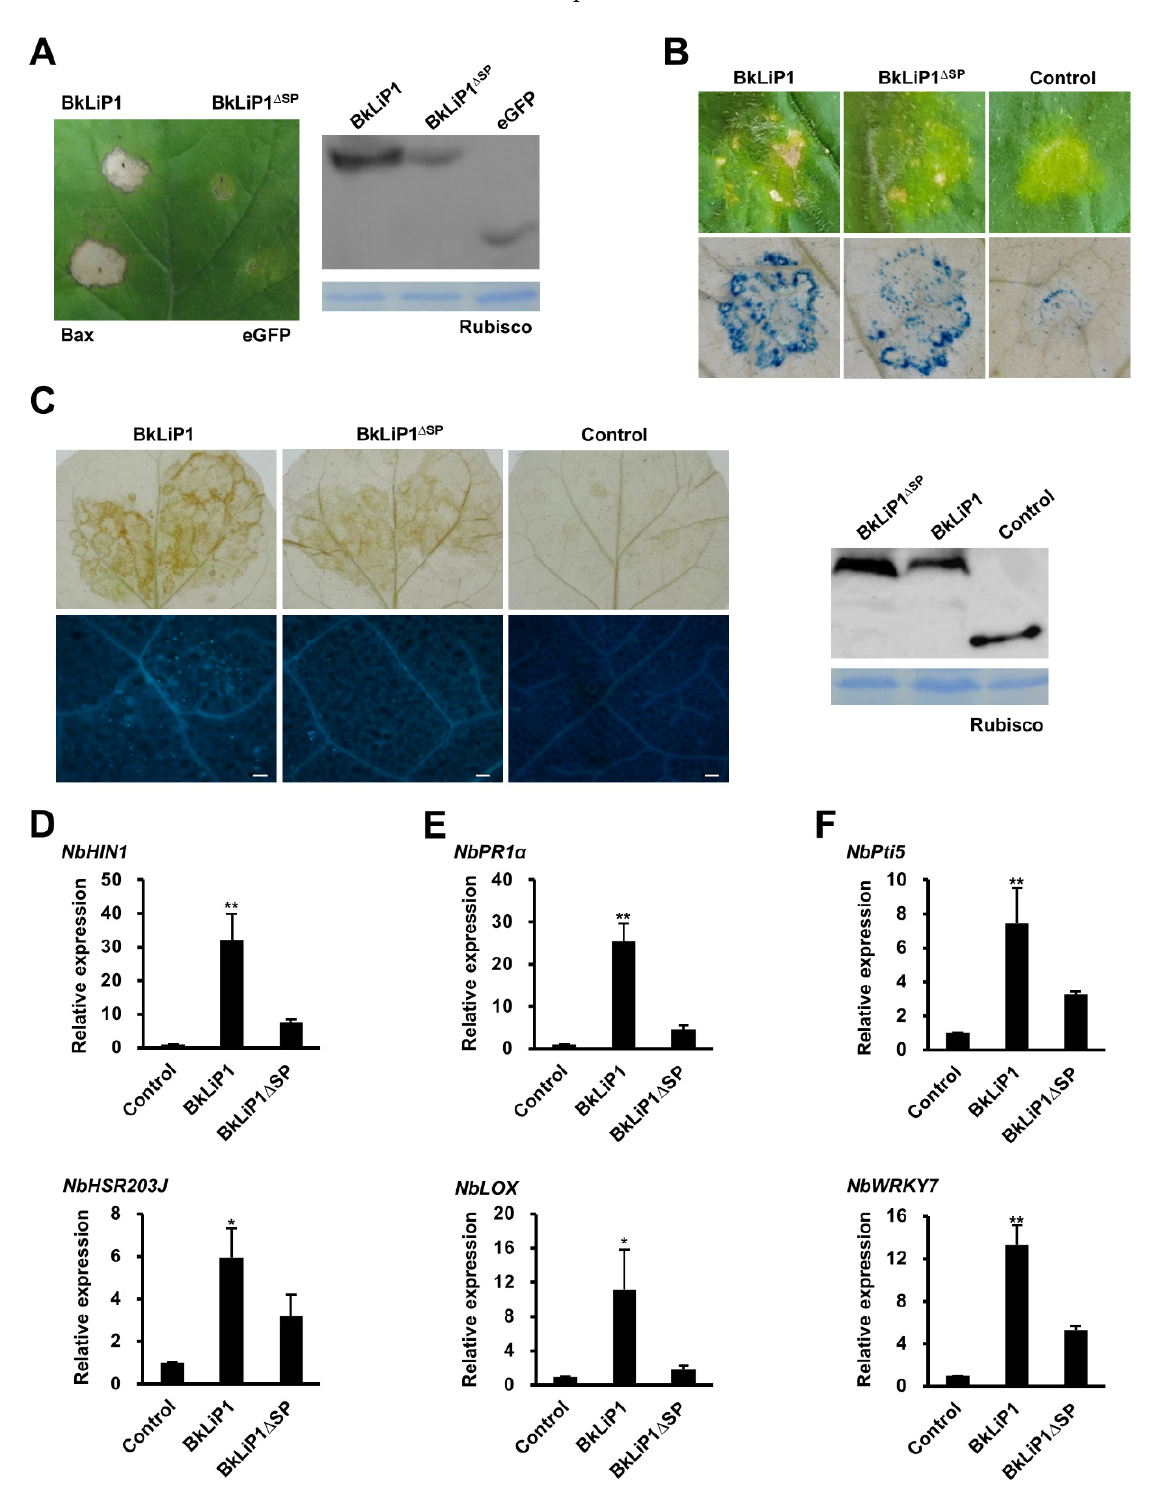
Figure 6. Immune responses triggered by BkLiP1 in N. benthamiana . ( A ) Programmed cell death triggered by transient expression of BkLiP1 in N. benthamiana leaves at 7 dpi infiltrated with Agrobacterium tumefaciens containing PVX-BAX, PVX-BkLiP1, PVX-BkLiP1 ∆ SP , and PVX-GFP vector, respec- tively. Western blot analysis was conducted to confirm protein expression with a Flag tag protein in N. benthamiana leaves 48 h after infiltrated by A. tumefaciens cells. ( B ) Cell death in N. benthamiana leaves at 13 dpi infiltrated with A. tumefaciens containing pCNF3-BkLiP1, pCNF3-BkLiP1 ∆ SP , and pCNF3- eYFP (control) vector, respectively. ( C ) Accumulation of reactive oxygen species (ROS, Up) and callose deposition (Down) in N. benthamiana at 2 dpi. Scale bar = 100 µm. Western blot analysis was conducted